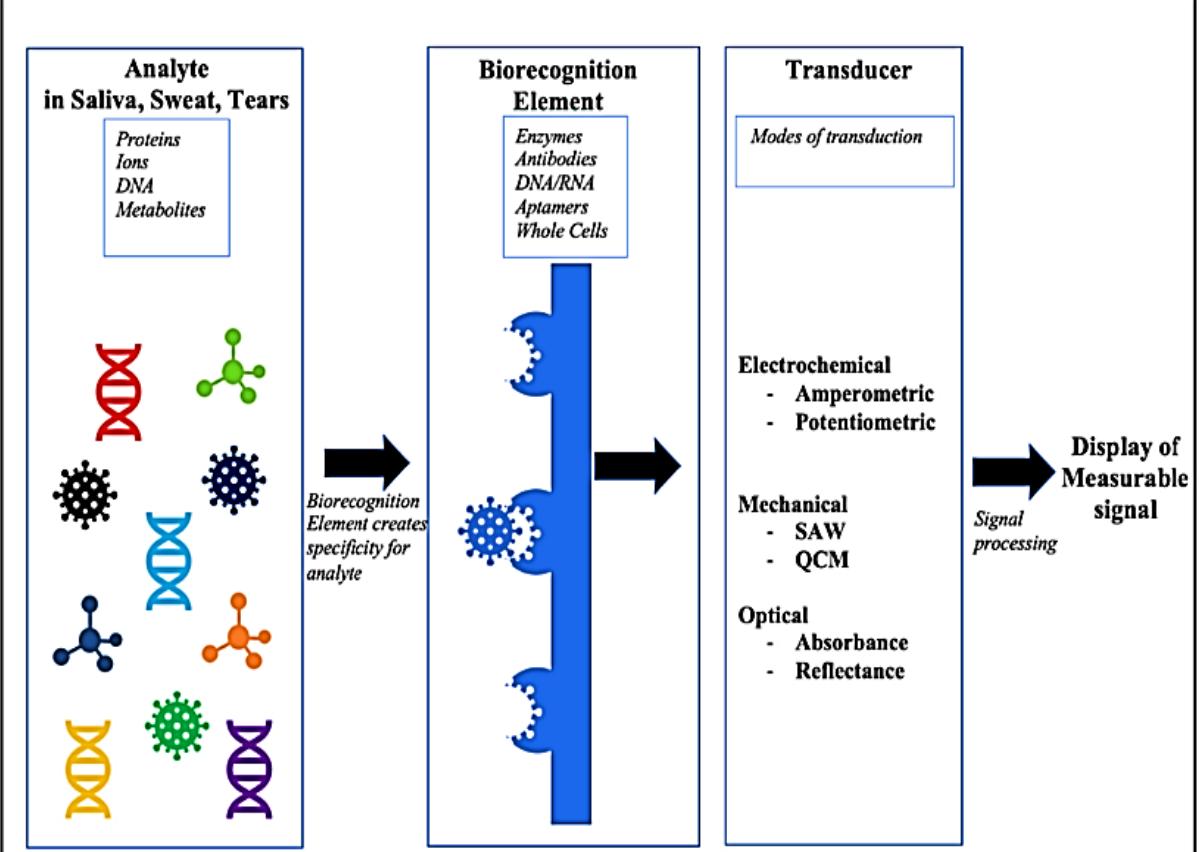
Figure 3. Basic parts of biosensors [39].